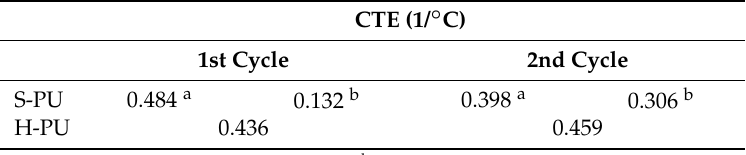
Figure 5. Thermal properties of S-PU and H-PU during the repeated heating cycle: ( a ) thermal expansion measured by TMA; ( b ) storage modulus versus temperature of S-PU in repeated DMA measurements. Table 2. The coefficients of thermal expansion (CTEs) of S-PU and H-PU.